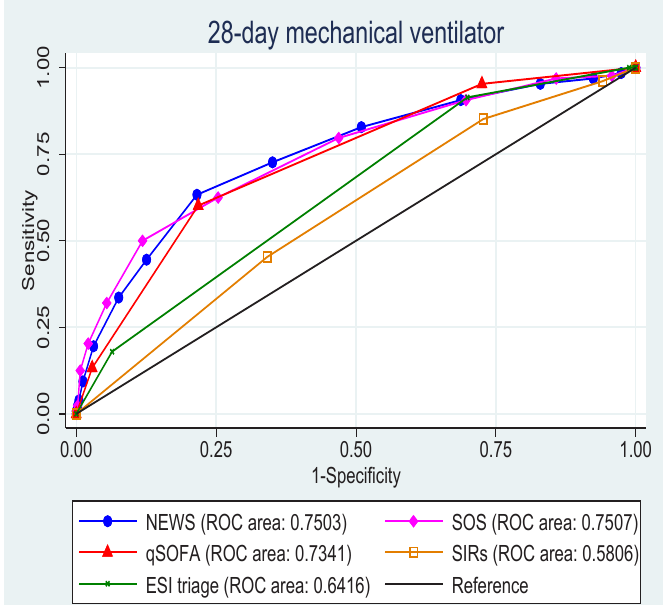
Figure 3. The AUROC of the predictive scores for predicting 28- day mechanical ventilator usage.